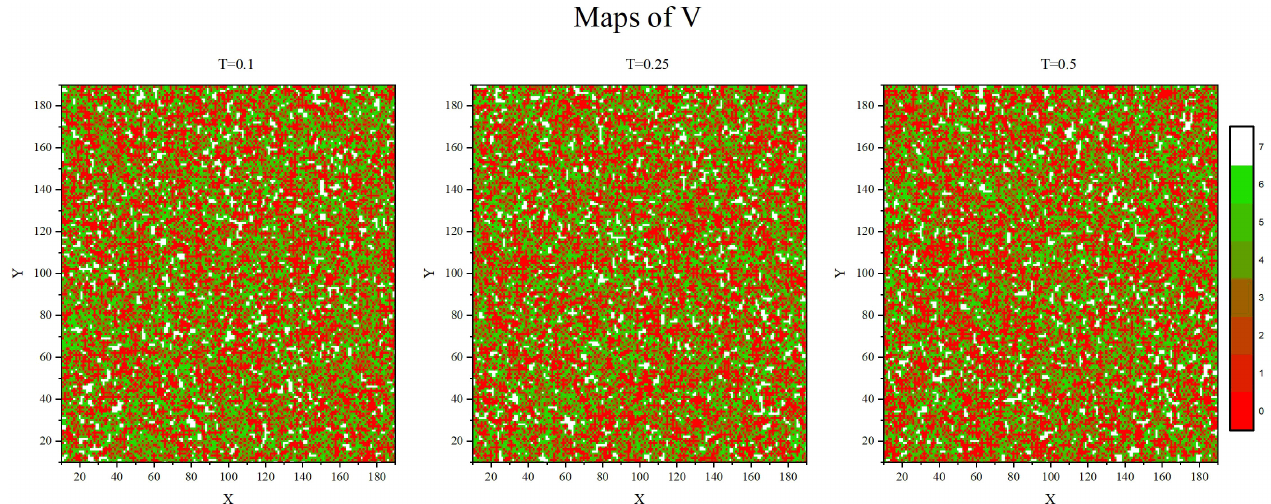
Figure 1. Instantaneous 2-dimensional maps of parameter V : T = 0.1 ( left ), T = 0.25 (close to glass transition, ( middle )) and T = 0.5 ( right